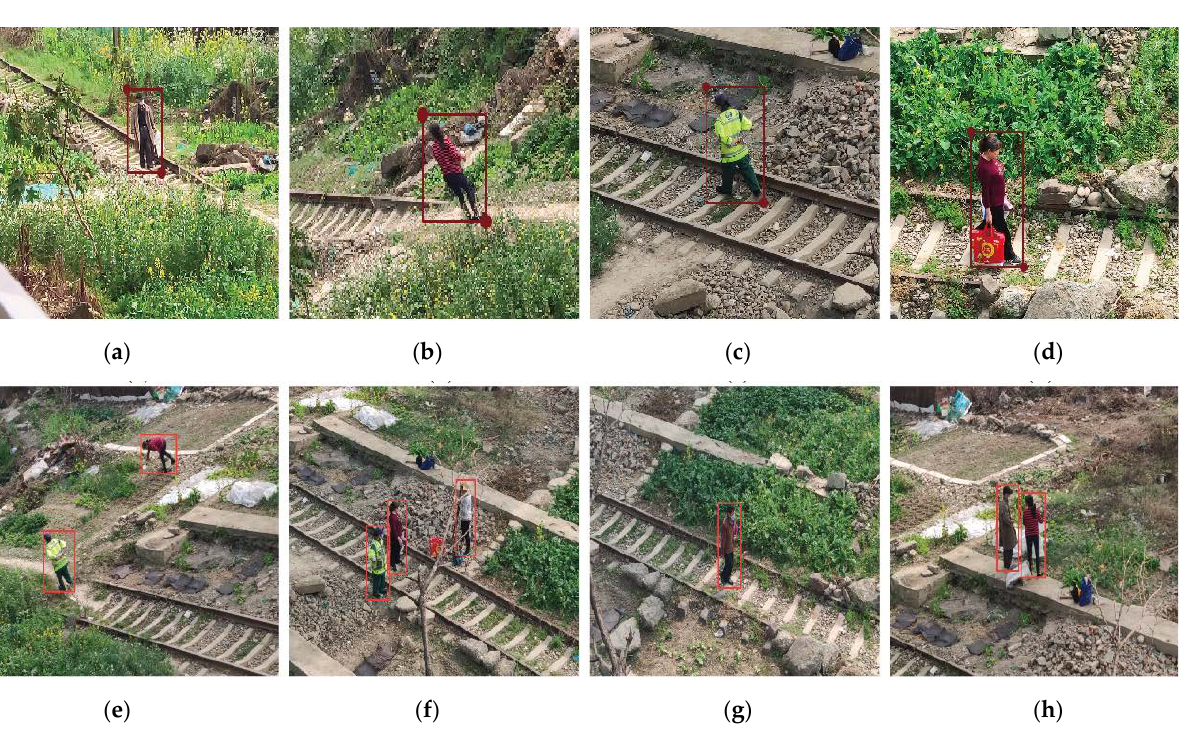
Figure 14. Self-made dataset annotation example. ( a ) self-made dataset 1; ( b ) self-made dataset 2; ( c ) self-made dataset 3; ( d ) self-made dataset 4; ( e ) self-made dataset 5; ( f ) self-made dataset 6; ( g ) self-made dataset 7; ( h ) self-made dataset 8.